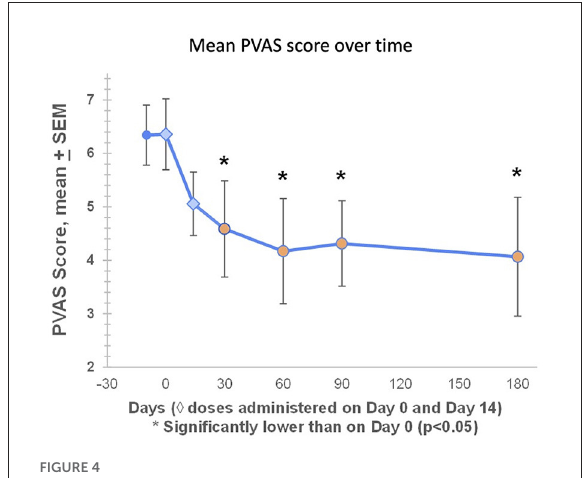
FIGURE4 At baseline, mean PVAS score was 6.4. Pruritus began improving after the first treatment, with mean PVAS scores significantly lower than baseline on Day 30 (4.6), Day 60 (4.2), Day 90 (4.3) and Day 180 (4.1). Mean percentage reductions in PVAS on Days 60, 90, and 180 were 34, 32, and 36%, respectively. On Day 60, three dogs (43%) had PVAS improvements of 60–78%, and five dogs (71%) achieved treatment success, defined as a PVAS reduction of at least 2 points (Figure 4). Six out of seven dogs (86%) achieved treatment success at any timepoint.